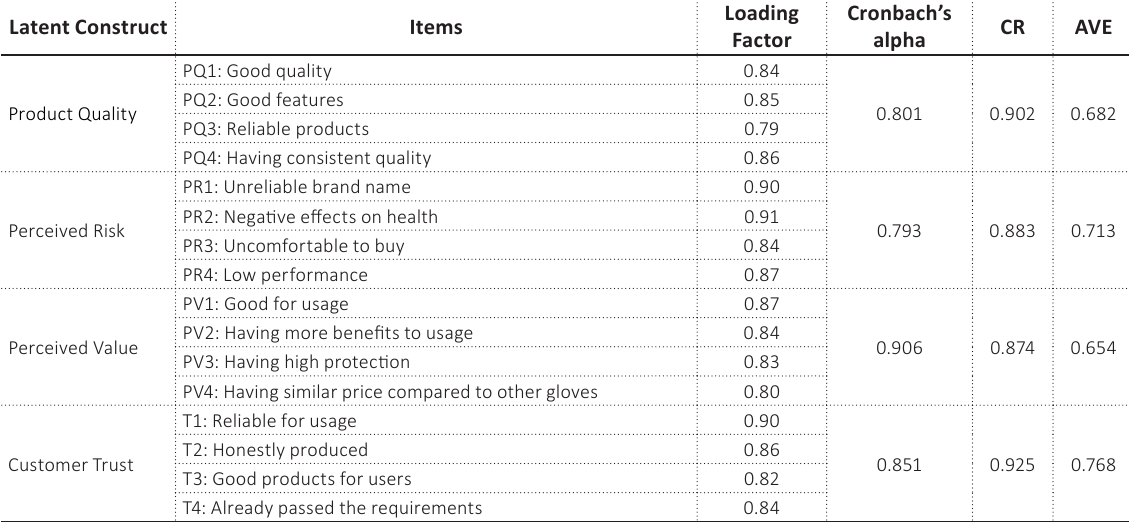
Table 2. SEM model